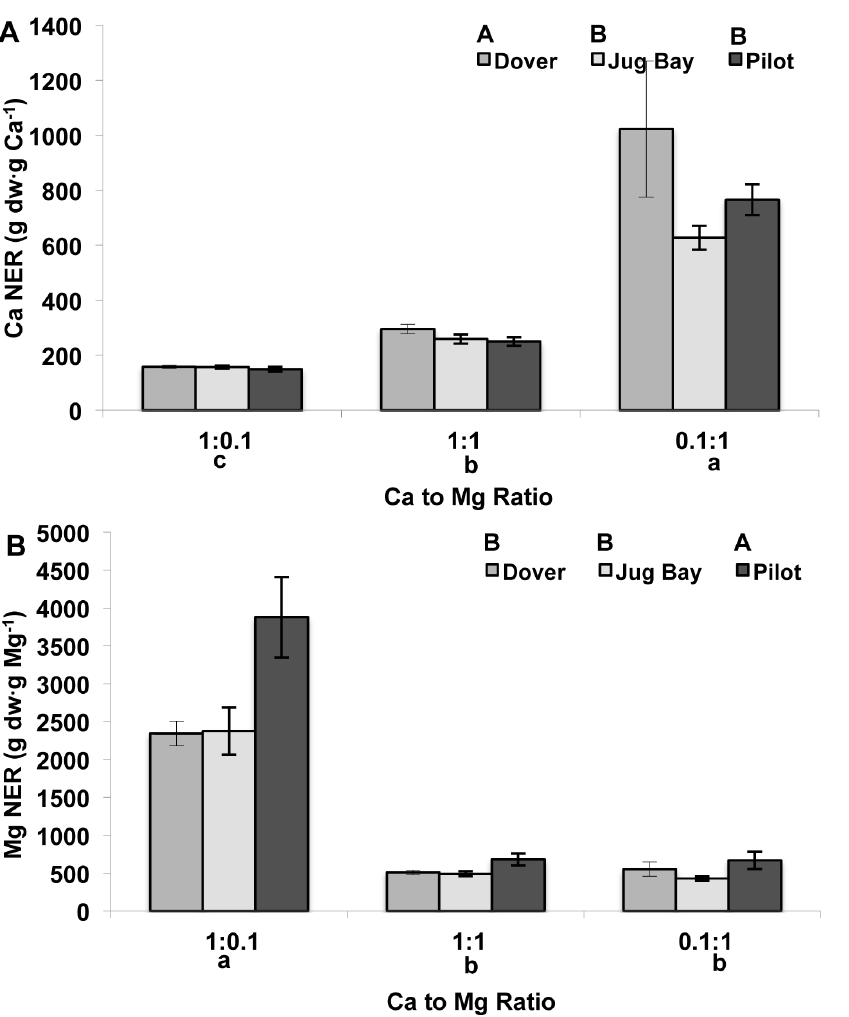
Figure 4. Rosette nutrient efficiency ratio (NER) of juvenile plants of three A.l. ssp. lyrata populations. A. Rosette Ca NER, and B. Rosette Mg NER. All data are presented as a mean 6 standard error (n=16). The plants were from serpentine (Pilot), limestone sand (Dover), and sandy loam (Jug Bay) soils. Different upper case letters indicate significant differences among populations, and different lower case letters indicate significant differences among substrate Ca to Mg ratios as separated by Tukey’s HSD (P , 0.05).